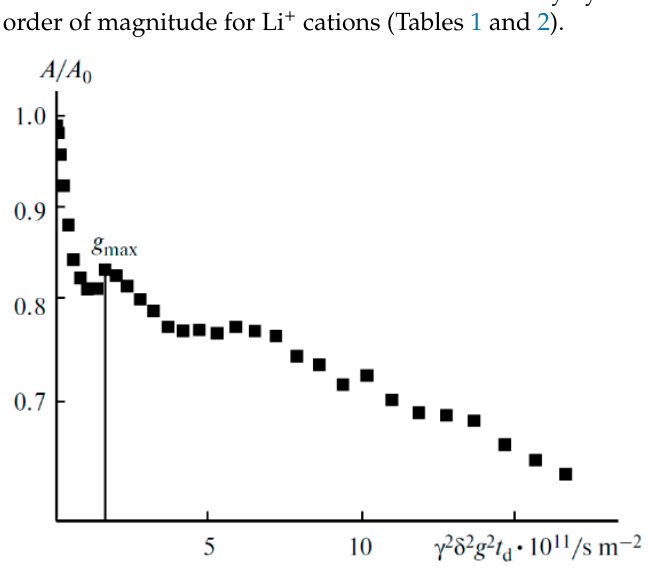
Figure 25. Diffusion decay on 7 Li for the composition of PE 1 [60]. Thus, a periodical network is initially formed in the polymer. Ionic liquid insertion decreases the linkage density, and the ionic and molecular mobilities increase. Solvent addition causes further network loosening, and restriction disappears, followed by the exponential diffusion decay (Figure 26). Ionic liquid ions and BF 4 − anions possess